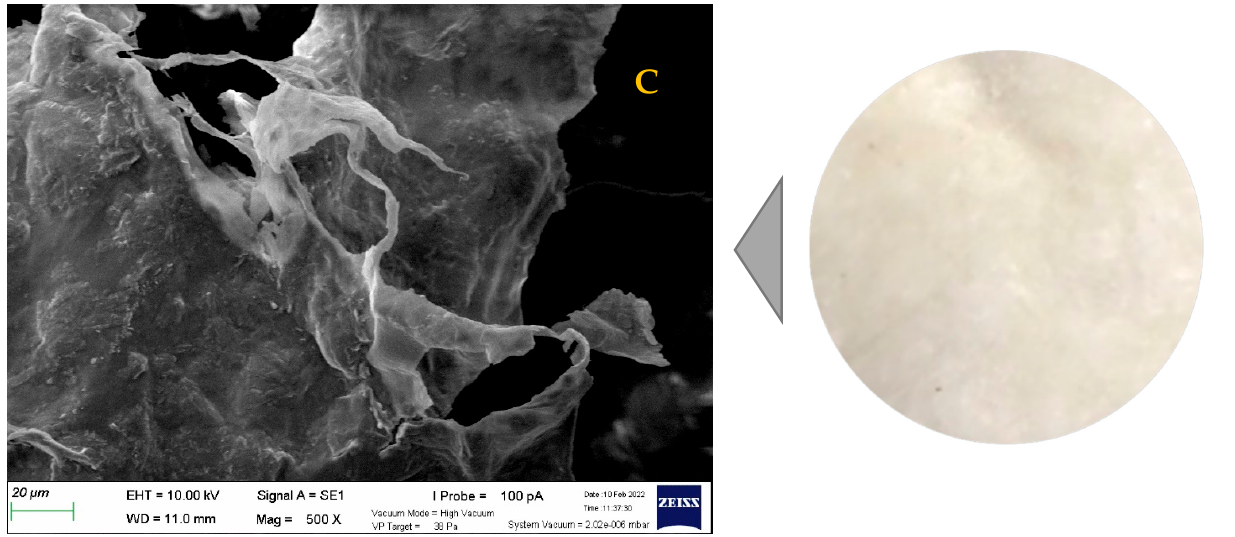
Figure 4. SEM image (magnification 500 × ) of the acid-soluble unicornfish ( N. reticulatus ) bone collagen. ( A ) acetic acid soluble collagen (AASC); ( B ) lactic acid soluble collagen (LASC); and ( C ) citric acid soluble collagen (CASC).